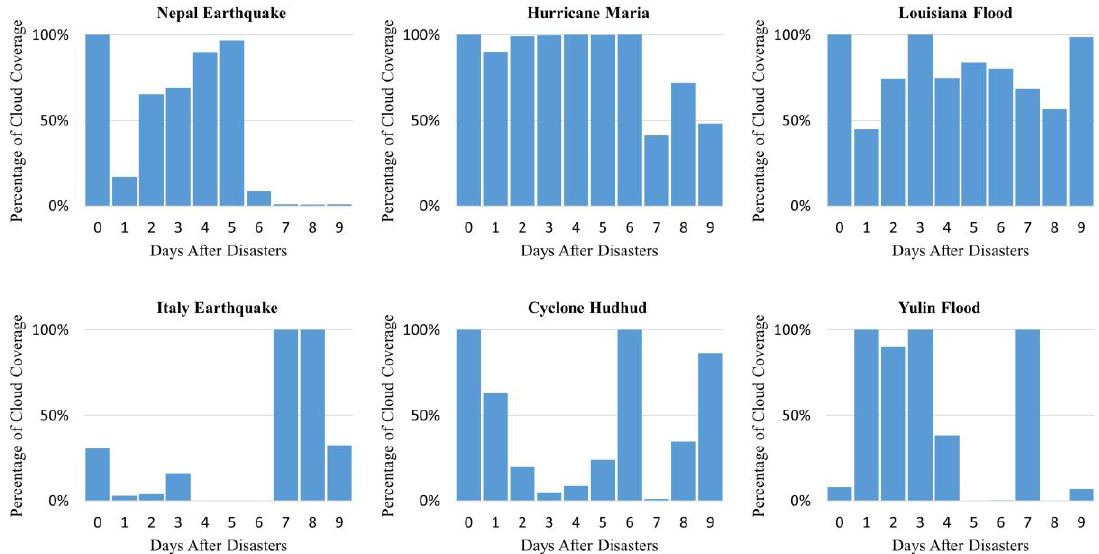
Figure 10. The percentage of cloud coverage in the study areas 10 days after each disaster.